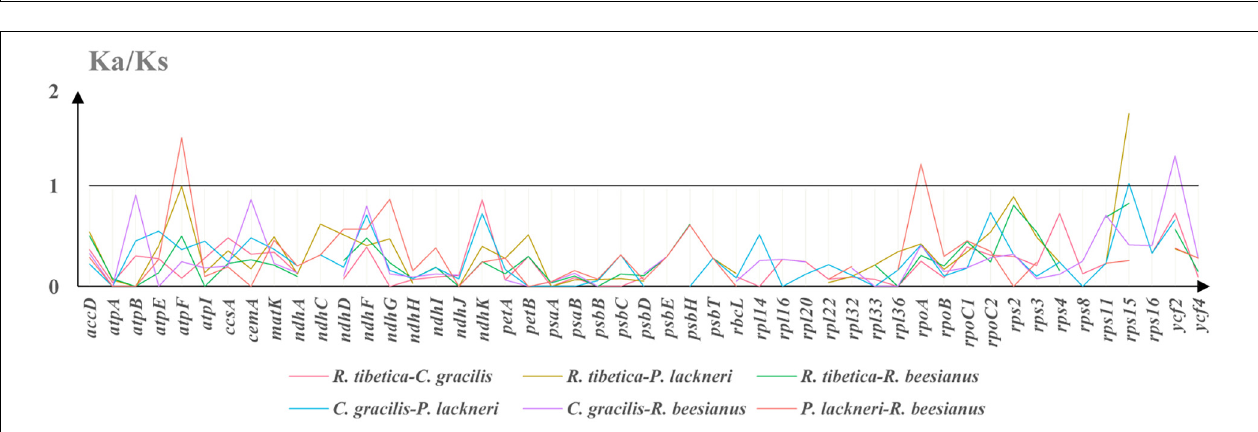
FIGURE 2 | Variation level of the Zingiberaceae chloroplast genome sequences, the y-axis indicates the level of variation (between 50 and 100%) and the x-axis represents the coordinate in the chloroplast genome.